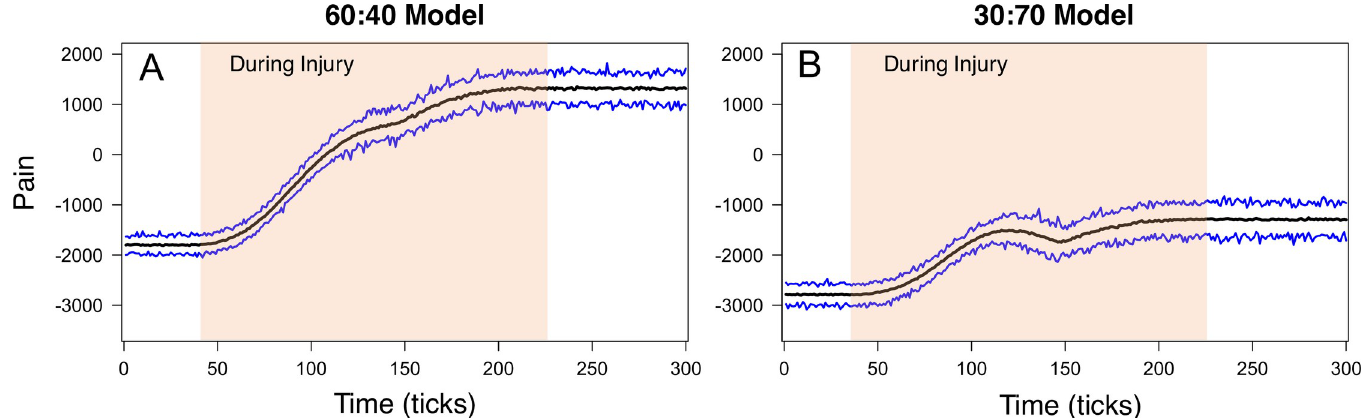
Fig 9. 60:40 and 30:70 model output. The 60(PKC δ ):40(SOM) model ( A ) and 30:70 model ( B ) were each simulated 100 times using constant 120 pA current and the average, minimum, and maximum pain output was plotted. In both models, pain increases during injury and remains elevated post-injury. However, in the 30:70 model a brief decrease in pain is observed around time t = 125 as spontaneous SOM neurons are converted to regular spiking.